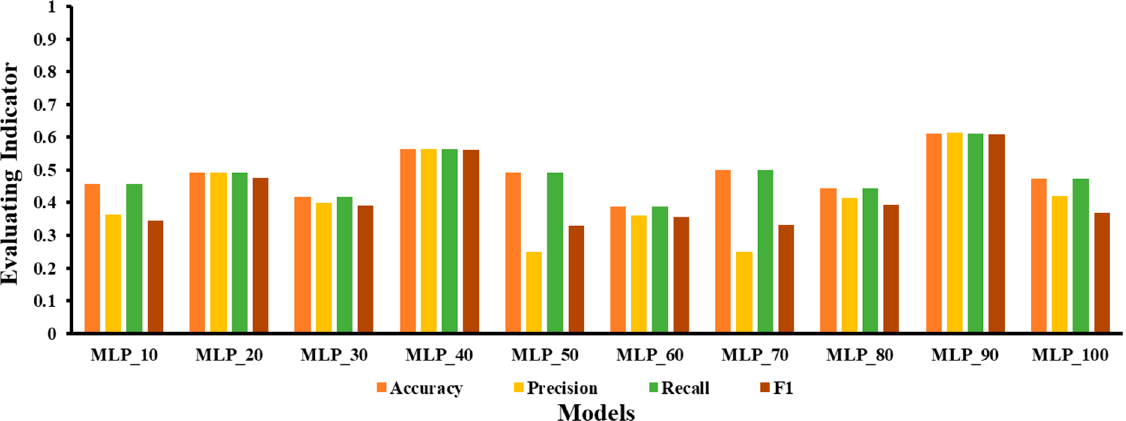
Figure 6. Plot of the validation set results when using MLP with different numbers of hidden layer nodes to build a classification model.